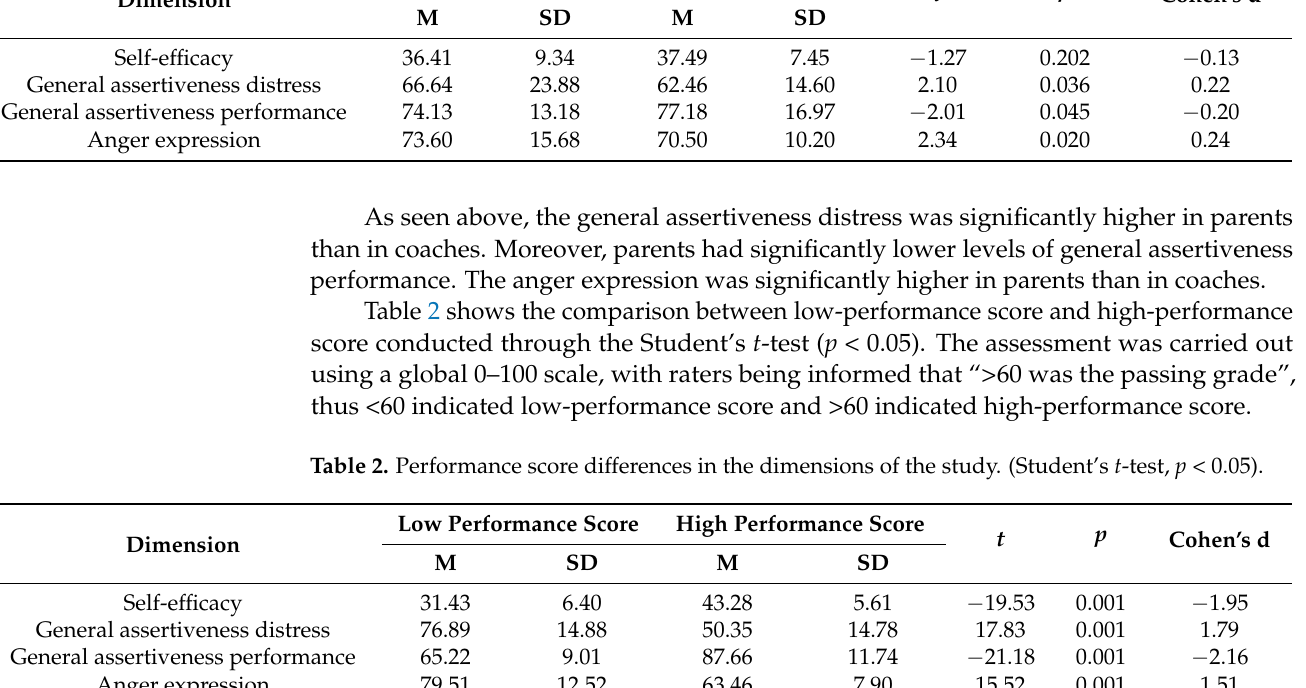
Table 1. Group differences in the dimensions of the study. (Student’s t -test, p < 0.05). Dimension